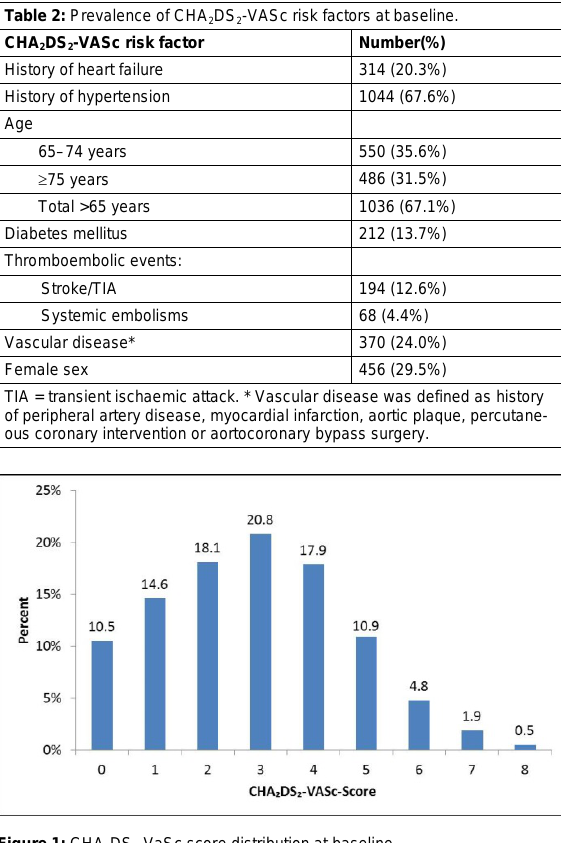
Figure 1: CHA 2 DS 2 -VaSc score distribution at baseline.